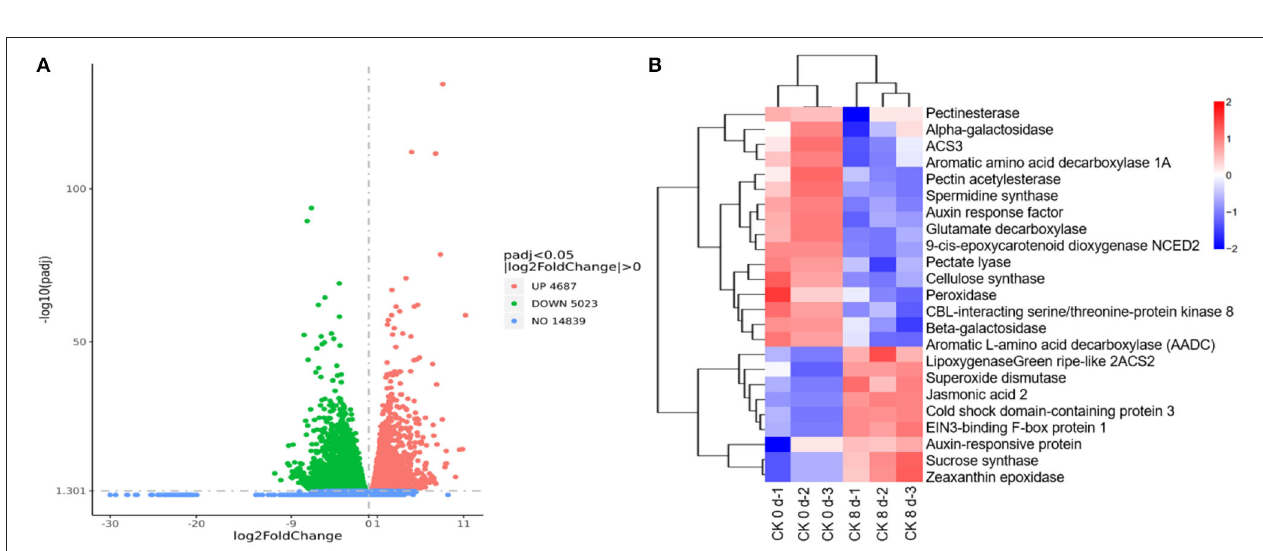
FIGURE 4 | Overview of transcriptome regulation of CI process in tomato fruit. (A) The volcanic map of DEGs of CK 8 vs. 0 day group. (B) Cluster heat map of DEGs of CK 8-day vs. CK 0-day group.